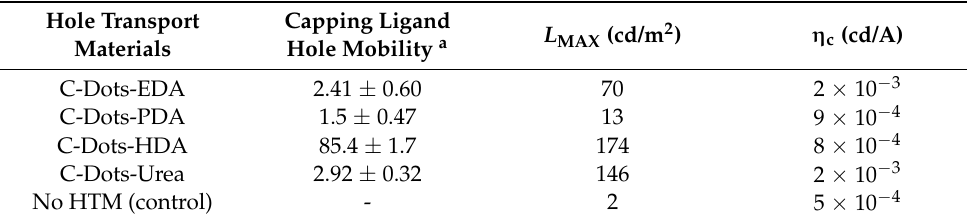
Table 2. Summary of the most relevant parameters of devices from Reference [90], including values obtained for a control device without hole transporting layer (HTL).